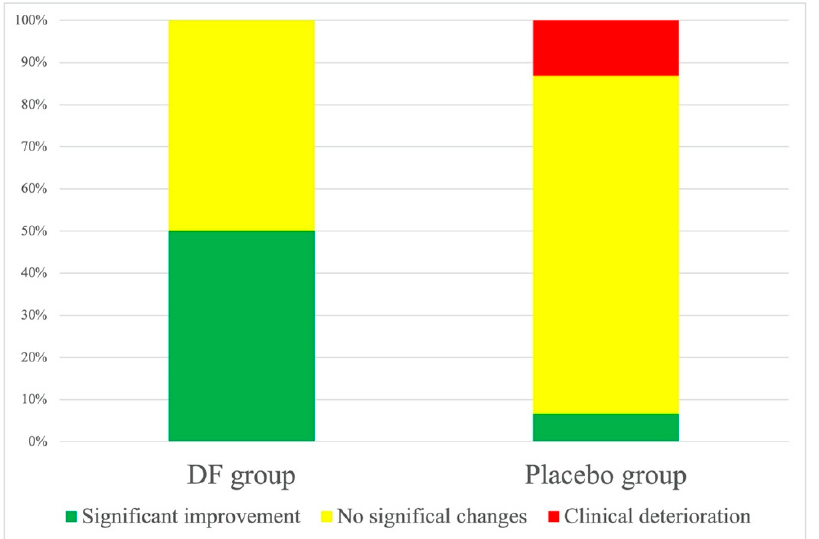
Figure 3. Graphical representation of subjective clinical change using the GROC scale.